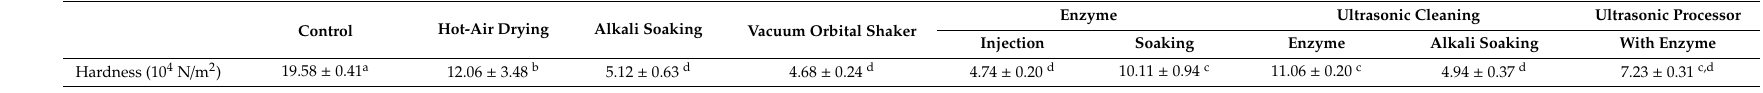
Table 4. Hardness of neritic squid muscle treated with di ff erent softening methods, versus untreated controls.